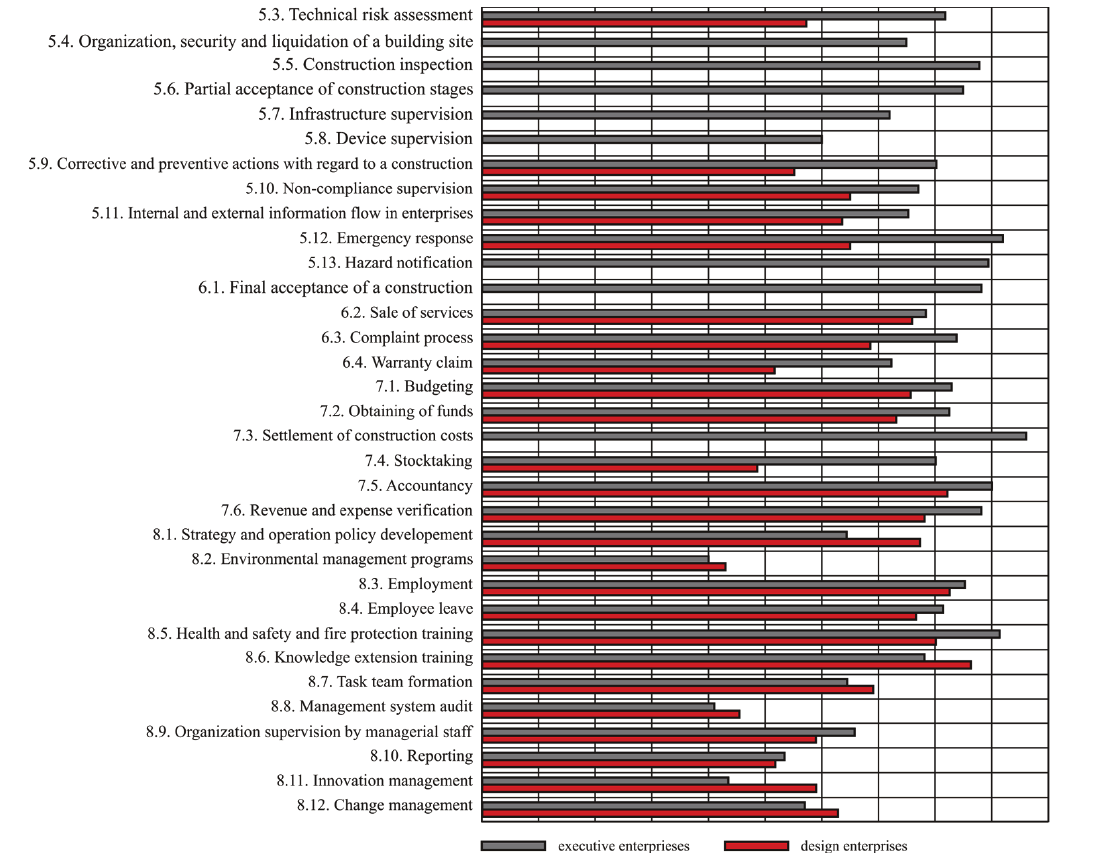
Fig. 4. a summary of processes surveyed in construction